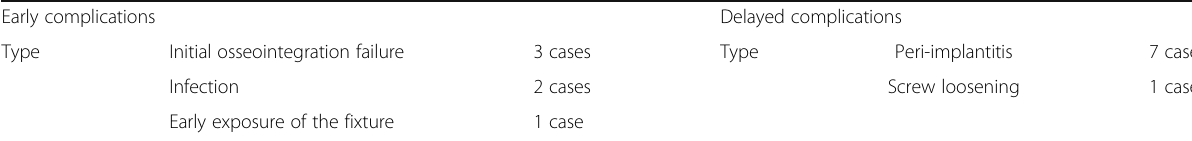
Table 1 Early and delayed complications